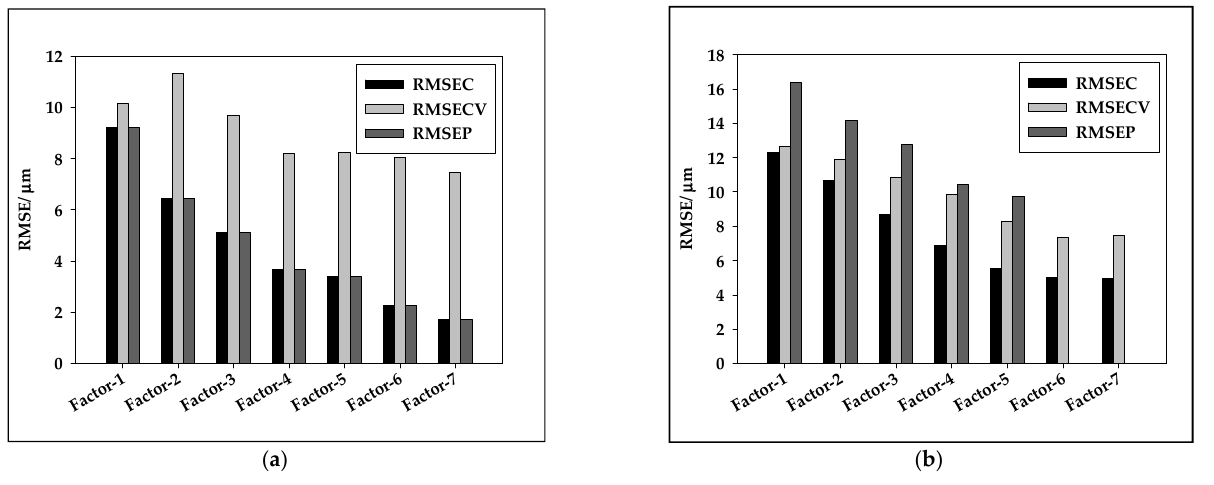
Figure 6. Variation in RMSEC, RMSECV, and RMSEP as a function of the latent variable number for